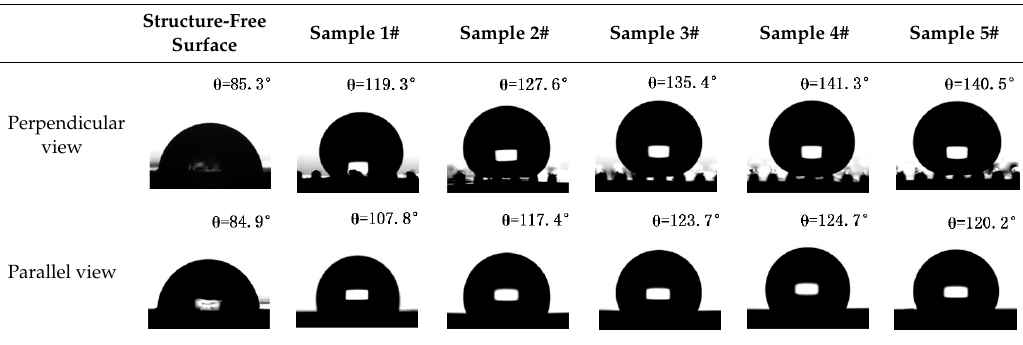
Table 5. WCAs on the surfaces of micro-structured parts.